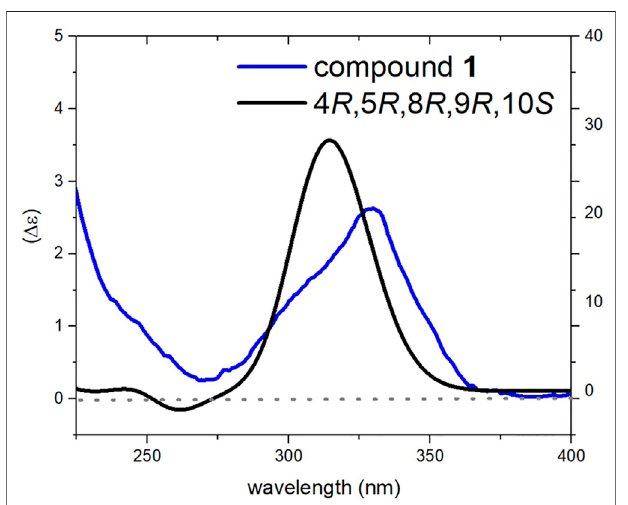
FIGURE 4 | Comparison of experimental and calculated ECD spectra of compound 1 at TD-DFT/cam-B3LYP/6-31G(d,p) level of theory in MeOH.